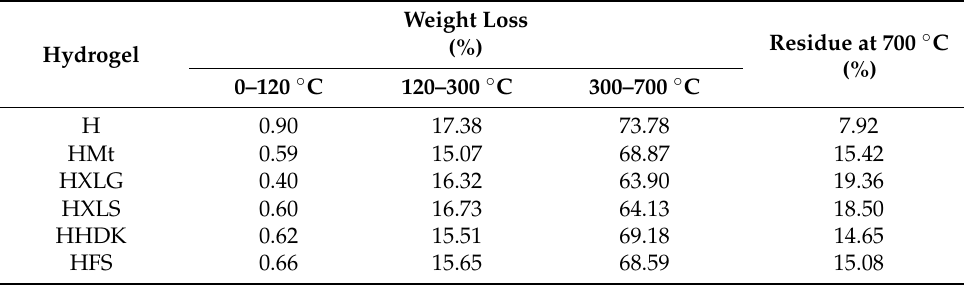
Figure 4. TGA curves for the composite xerogels obtained. Table 2. TGA/DTG results obtained for the investigated composite xerogels.